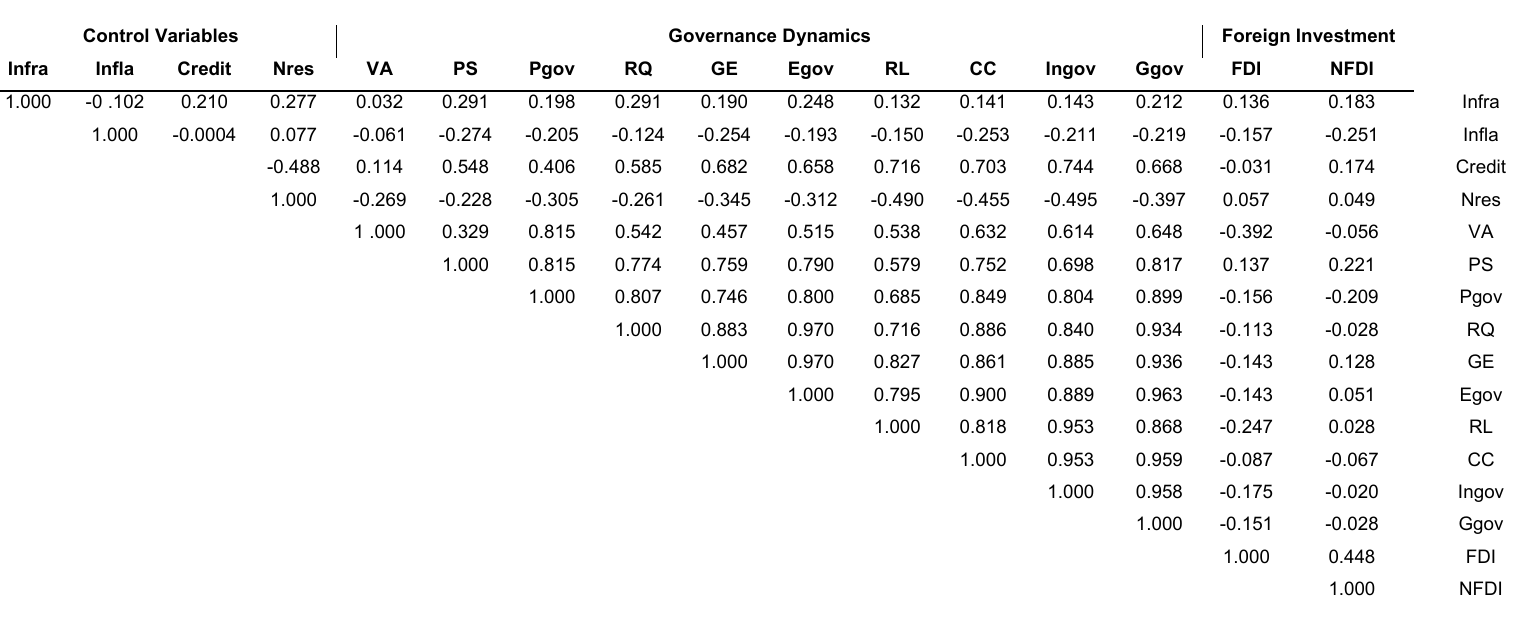
Table 6: Correlation Matrix (n for panel A =90)